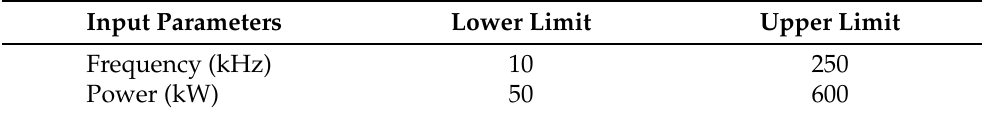
Table 2. Input parameters and their lower and upper